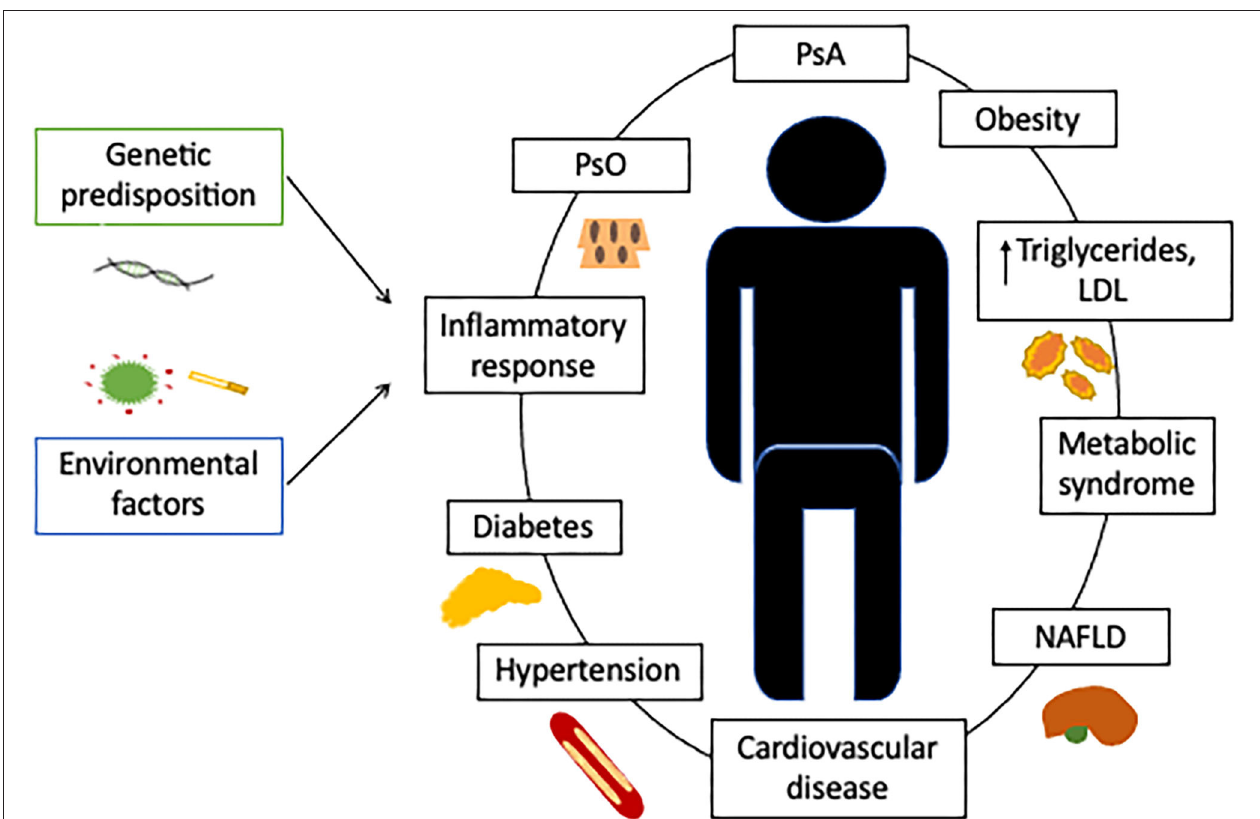
FIGURE 1 | Cardiovascular comorbidities in patients with psoriatic arthritis. Although PsA can be associated with a higher prevalence of cardiovascular risk factors, these conditions do not fully account for the greater incidence of cardiovascular events. Associated factors, such as chronic systemic inflammation, a predisposing genetic background, or the baseline treatment, must contribute to the higher cardiovascular risk. Comorbidity is defined as the existence of any additional entity during the clinical course of a patient who has the index disease under study, such as PsA. In the comorbidity concept, the management and treatment are primarily focused on the index disease and the effect quantified by evaluating the disease activity. In the multimorbidity concept, the patient is of central concern and all coexisting diseases are of equal importance with interactions between each other. In the multimorbidity concept, the management and treatment focus on the patient and effectiveness is quantified by overall indicators such as quality of life or physical function ( 5). This new approach compels us to tackle with PsA patients from a multidisciplinary perspective. PsO, psoriasis; PsA, psoriathic arthritis; LDL, Low-density lipoprotein; NAFLD, Nonalcoholic fatty liver